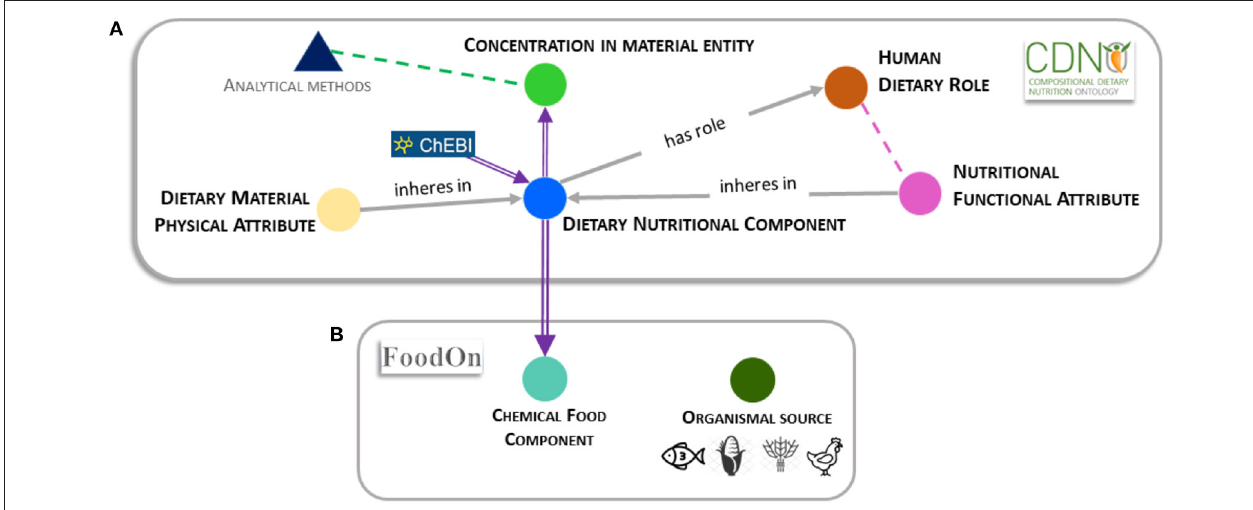
FIGURE 1 | Compositional Dietary Nutrition Ontology (CDNO) class relationships and interaction with FoodON. (A) Relationships and associations between major ontology classes. Solid symbols (circles and triangle) represent class hierarchies that may be used individually or in combination by curators to annotate datasets in the continuum between agriculture and health. Many terms within the ‘ dietary nutritional component ’ (blue solid circle) hierarchy are imported and reused from ChEBI (purple arrow). Grey arrows indicate relationships between independent classes that may in future be adopted where evidence is available. The ‘ dietary nutritional component ’ [CDNO:0000001] provides a framework where terms are reused in the ‘ concentration of dietary nutritional component in material entity ’ [CDNO:0200001] class hierarchy (green solid circle). A distinction is made between the latter class and that required an independent ‘analytical methods’ class ( Figure 1 , blue triangle) to provide vocabulary to describe analytical methods where terms would be used in combination to represent relevant metadata ( Figure 1 , green dotted arrow). The ‘ dietary material physical attribute ’ class [CDNO:0400001] (cream solid circle) provides structured subclasses to describe properties that may inhere either in a food material or be associated with a specific ‘ dietary nutritional component ’ [CDNO:0000001]. The ‘ nutritional functional attribute ’ [CDNO:0300001] class hierarchy (pink solid circle) allows the description of quantifiable functional attributes that may be associated with or inhere in terms from the ‘ dietary nutritional component ’ [CDNO:0000001] class hierarchy. Where evidence is available, terms from this class may also be associated with a human dietary role ( Figure 1 , pink dotted line). The ‘ human dietary role ’ [CDNO:0500001] class (orange solid circle) includes structured terms representing biological roles that may be assigned to a specific ‘ dietary nutritional component ’ [CDNO:0000001], where it is left to experts and data curators to assign supporting evidence that indicates a function defined at the levels of molecular interaction, cellular process or physiological role. (B) The interaction between CDNO and FoodOn is shown with a purple double arrow. FoodOn reuses ∼ 500 terms from the CDNO ‘ dietary nutritional component ’ [CDNO:0000001] hierarchy within the ‘ chemical food component ’ [FOODON:03411041] hierarchy (cyan solid circle). The FoodOn ‘ food product by organism ’ [FOODON:00002381] class (olive solid circle) is not directly associated with CDNO classes, but can be used